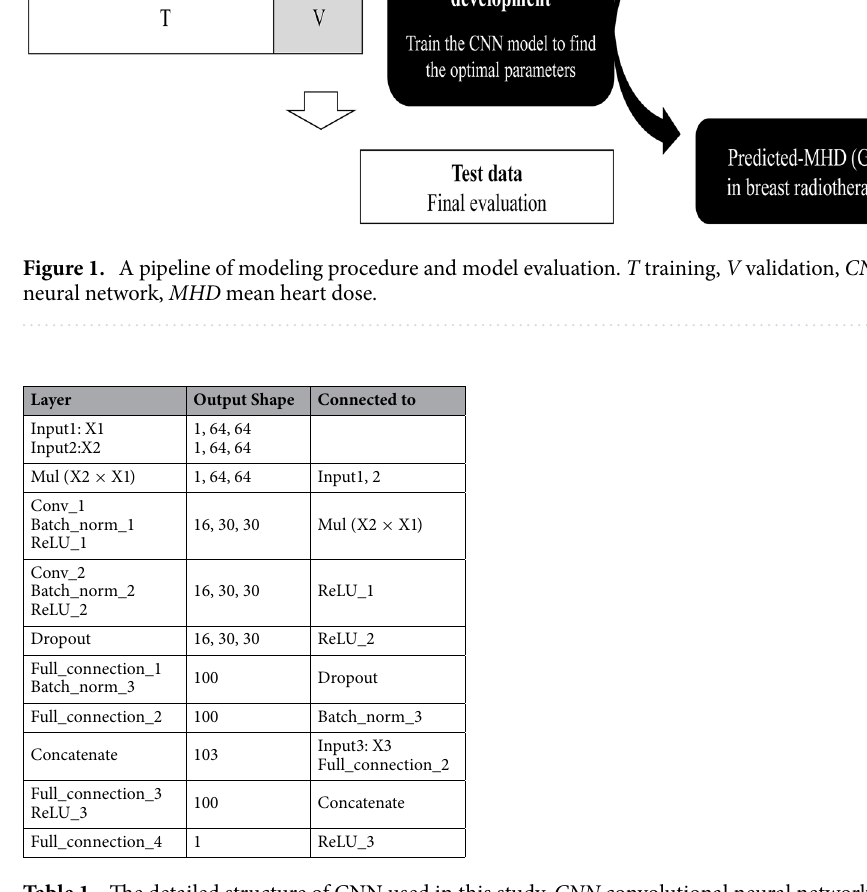
Table 1. The detailed structure of CNN used in this study. CNN convolutional neural network, Mul multiply, Conv convolution, Batch_norm batch normalization, ReLU rectified linear unit.